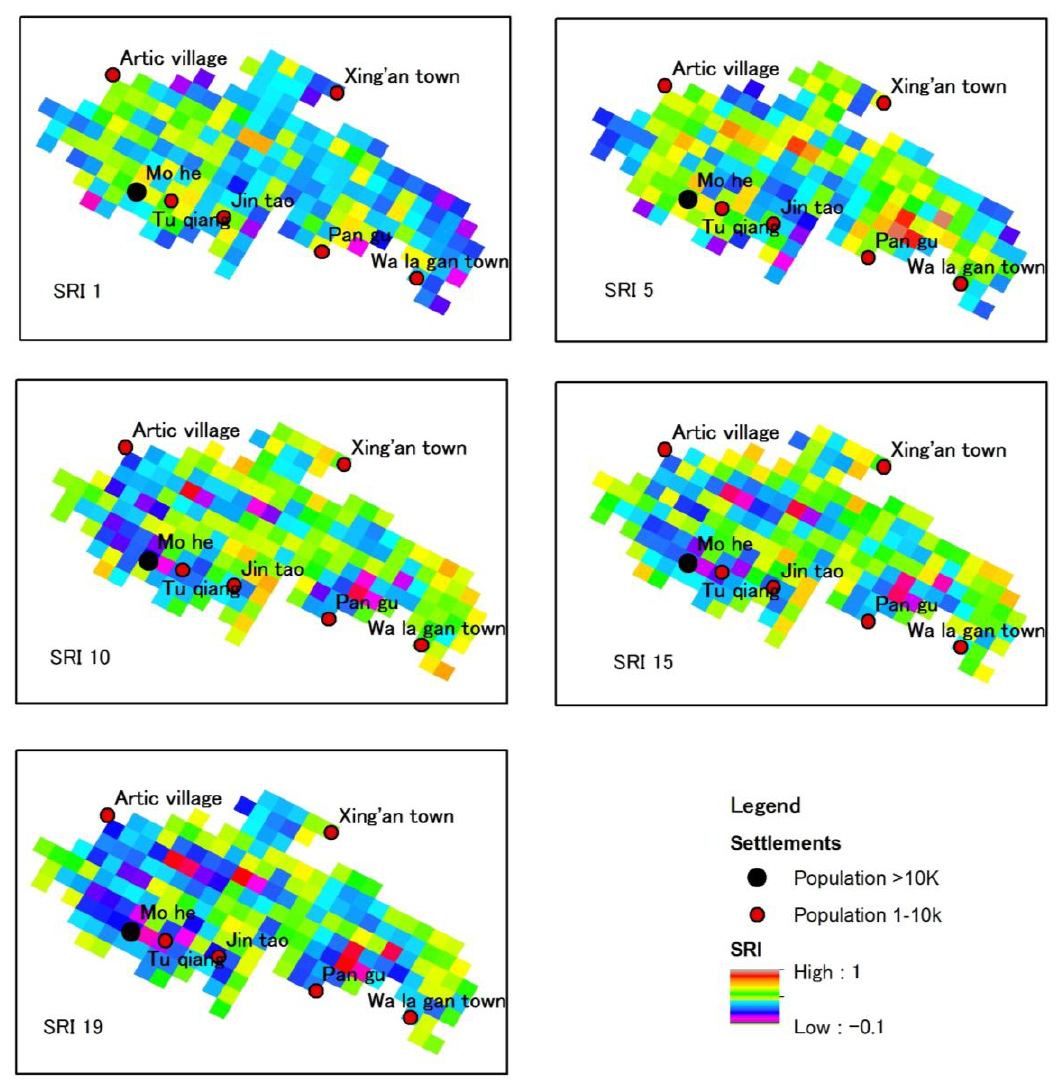
Figure 8. The trajectory of the post-fire stands regrowth index (SRI) for the relative year 1, 5, 10, 15 and 19.